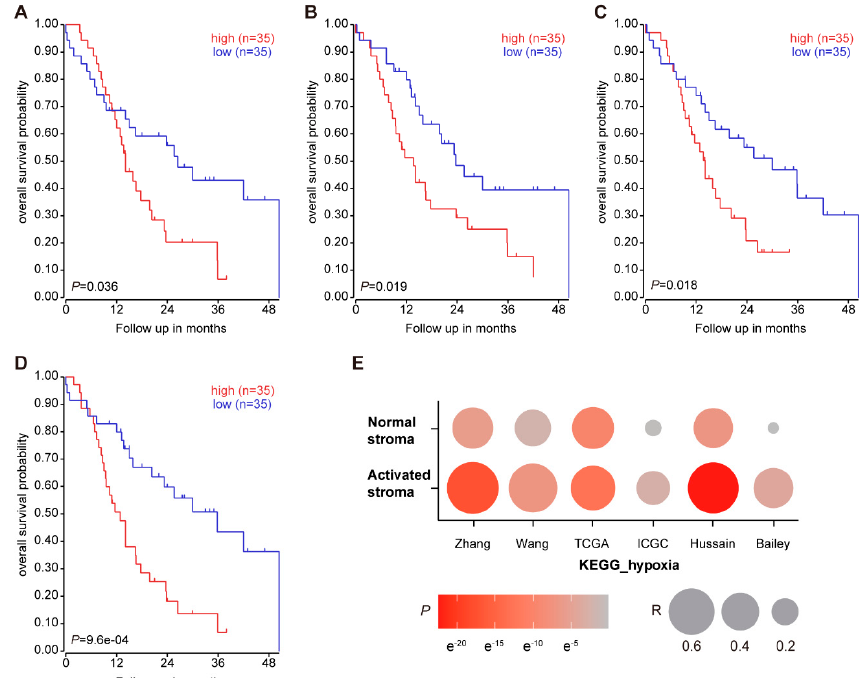
Figure A1. Hypoxia signatures associate with poor outcome and stroma activation in PDAC. ( A ) PDAC samples from the Bailey dataset were used. Kaplan–Meier survival analysis was performed by a hypoxia geneset expression and dichotomized by median. The curves are shown using genesets response to hypoxia, reactome regulation of hypoxia inducible factor hif by oxygen ( B ), reactome regulation of gene expression by hypoxia inducible factor ( C ), and semenza hif1 targets ( D ). ( E ) The correlation between normal/activated stroma genesets and hypoxia KEGG signaling pathway geneset was analyzed in six datasets as indicated. p value is indicated by color, correlation coefficient (R) by size of dot.